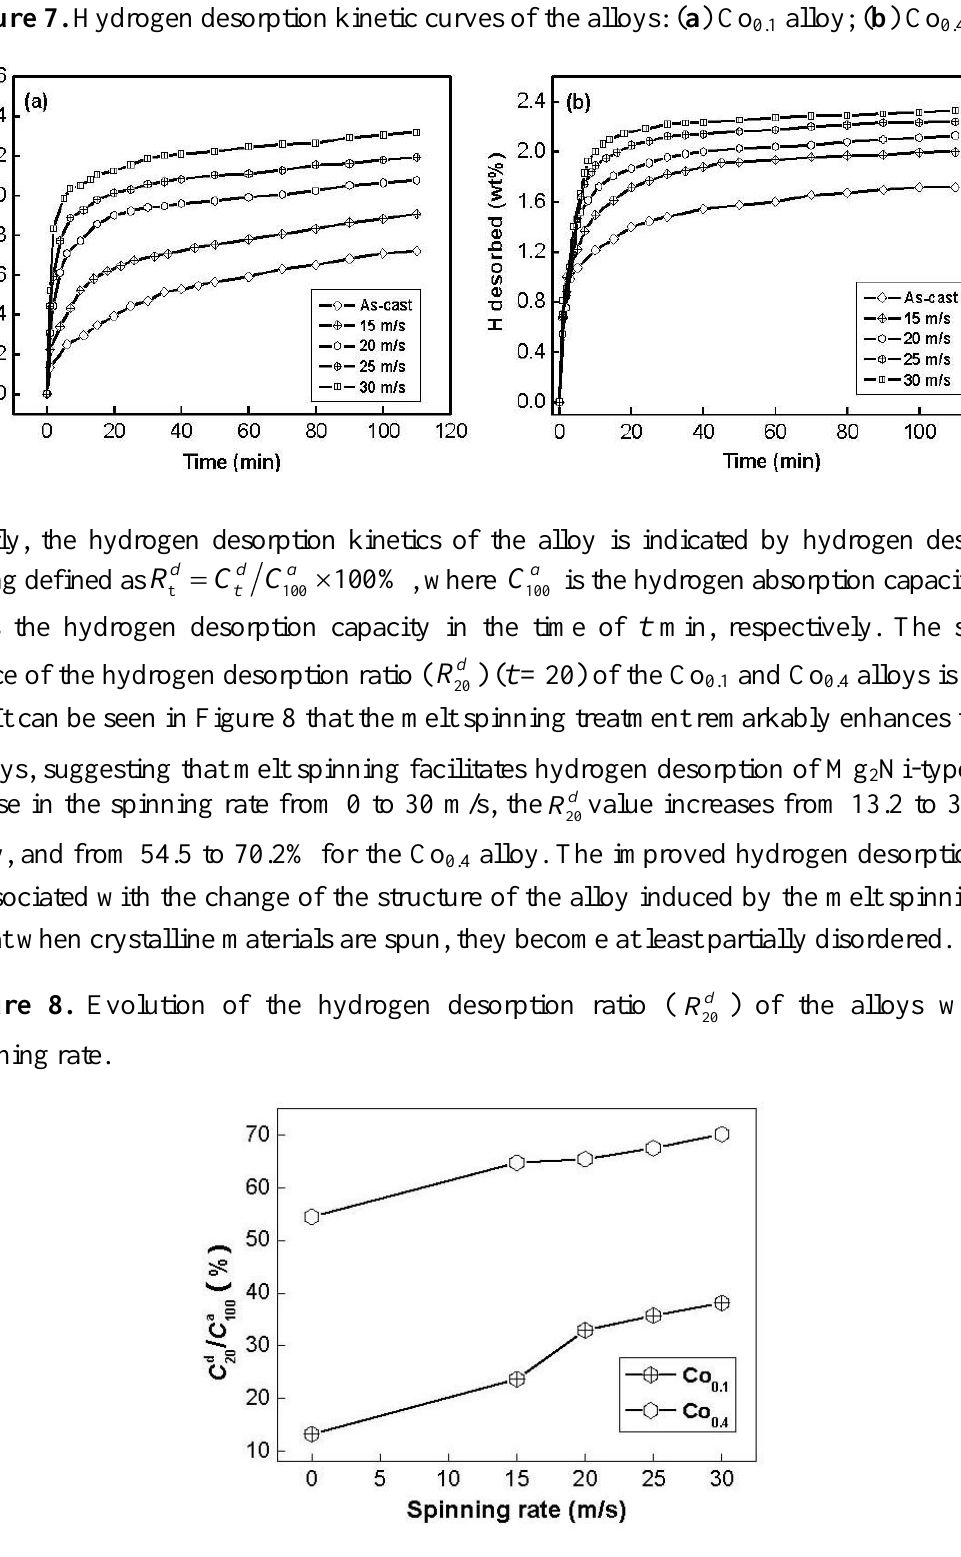
Figure 7. Hydrogen desorption kinetic curves of the alloys: ( a ) Co